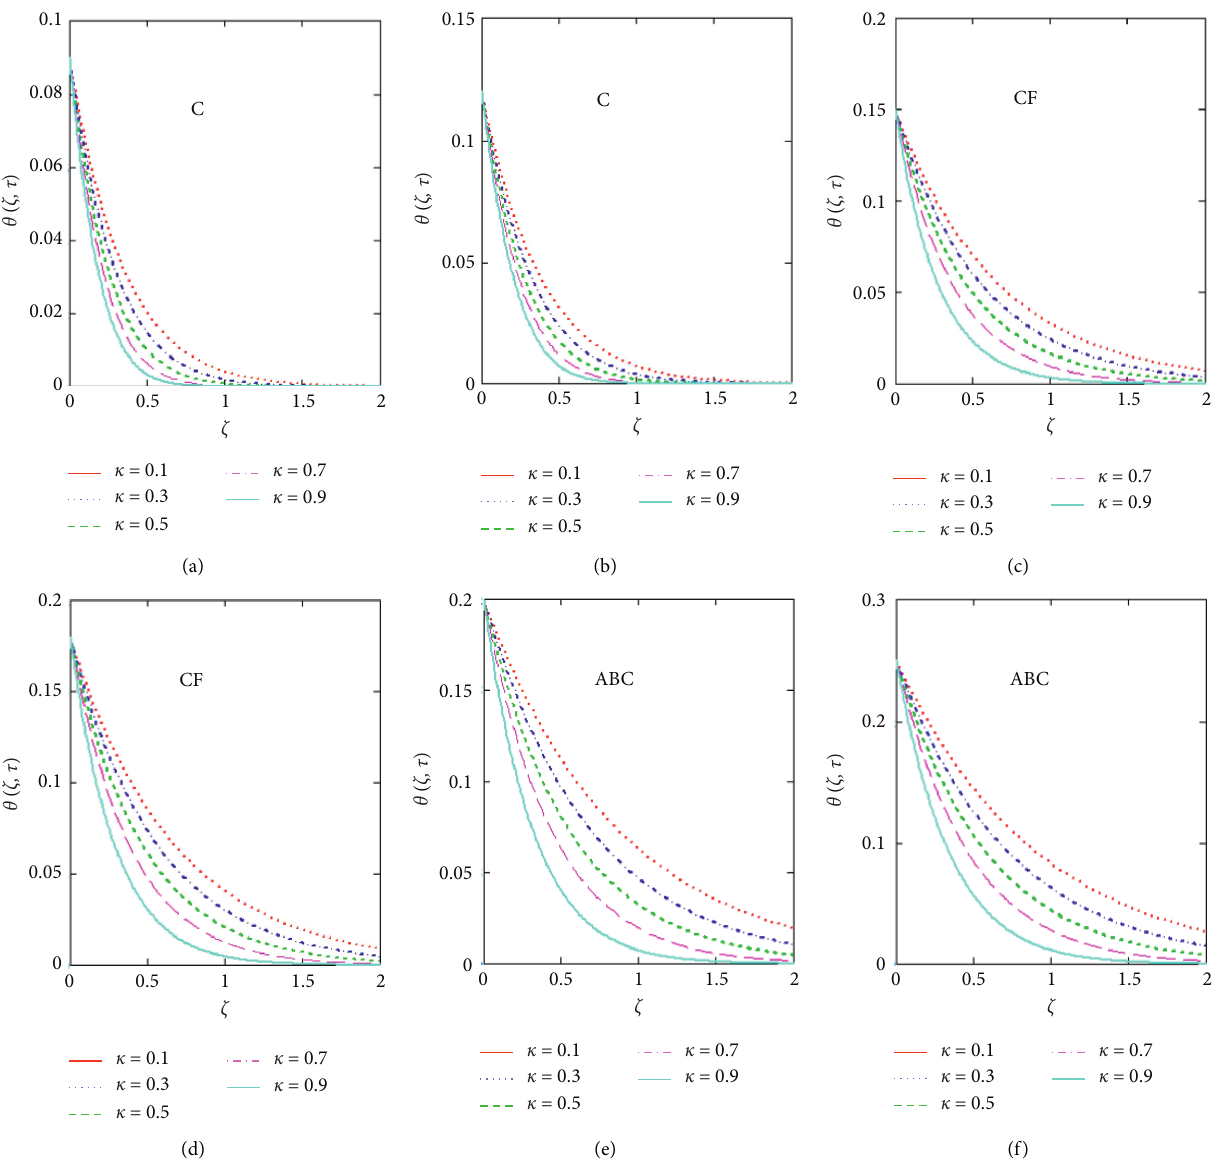
Figure 9: Plot via C, CF, and AB approaches for the temperature profile with different values of κ